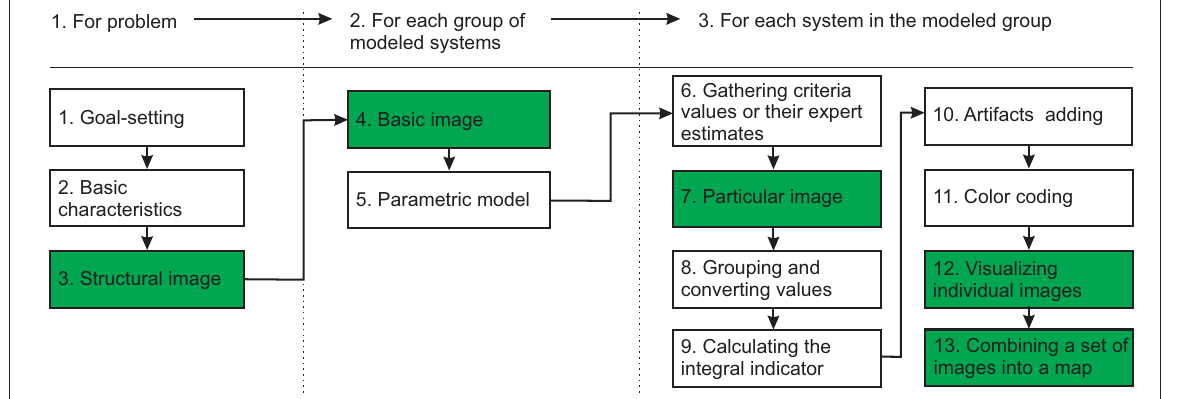
Figure 5. Stages of creating images in the UGVA